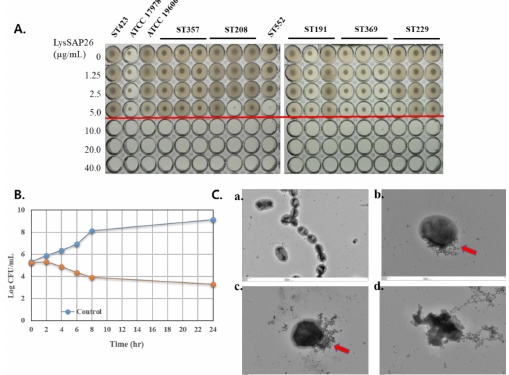
Figure 2. Antibacterial activity of LysSAP26. ( A ) Antimicrobial activity (MIC) test results of